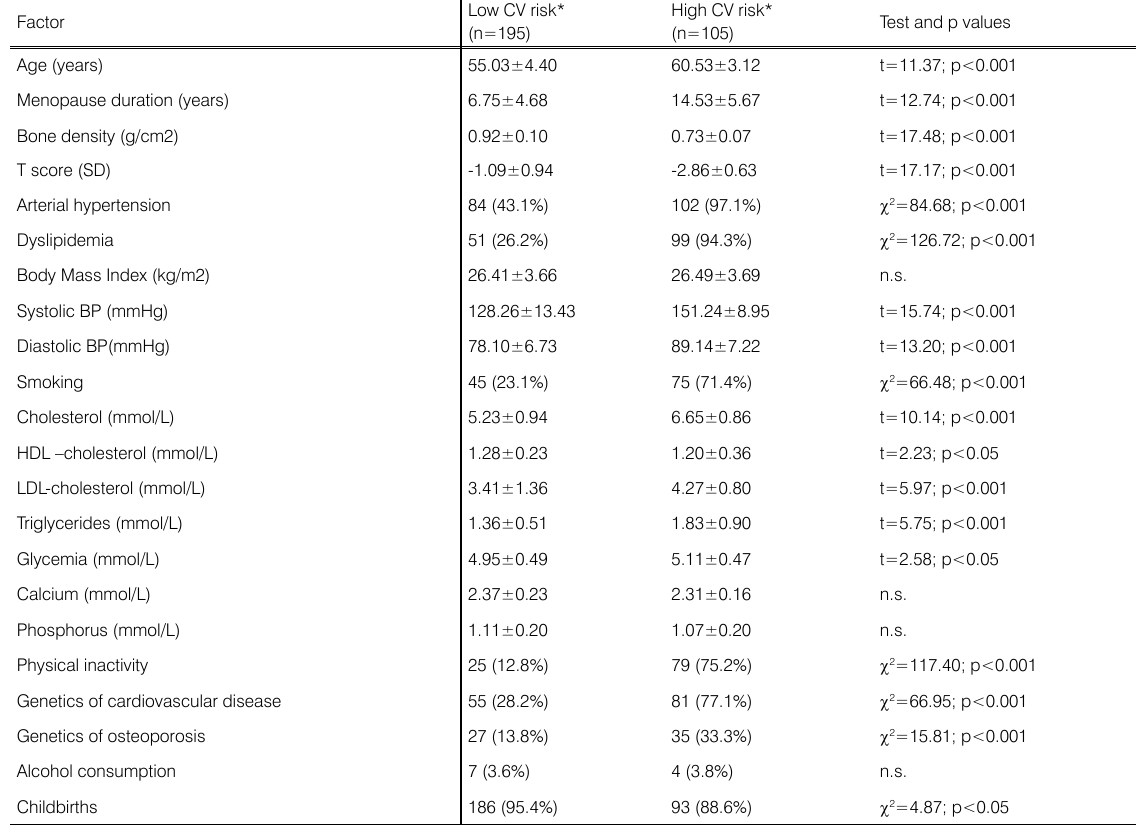
Table 1. Values and distribution of relevant features in respect to total cardiovascular (CV)